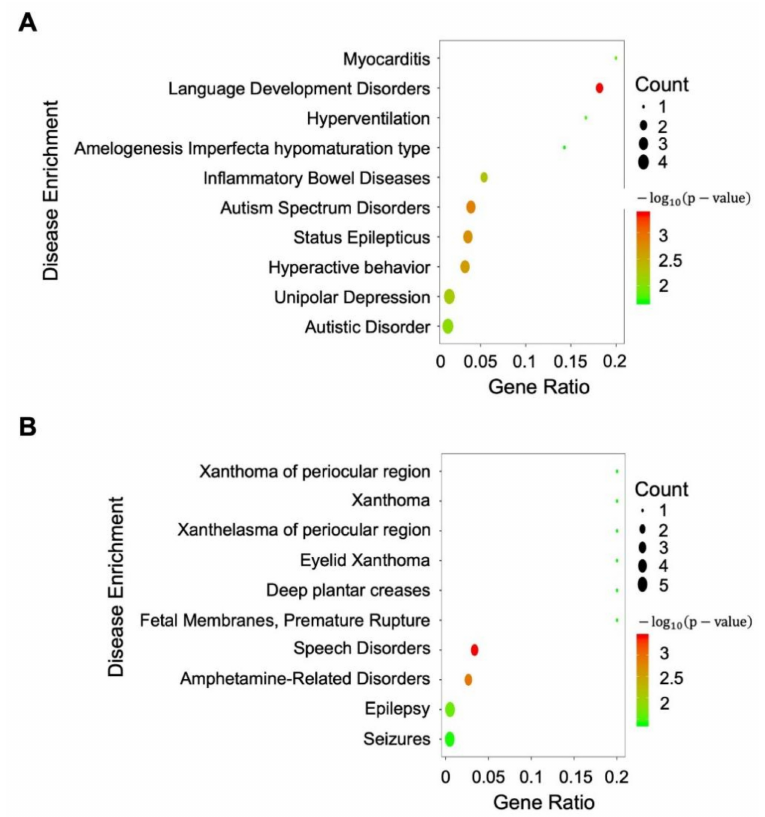
Figure 5. The pathway enrichment analysis of differentially expressed neighboring genes near differentially expressed HERVs. ( A ) For genes neighboring MER11B_LTR_ERVK; ( B ) for genes neighboring LTR21A_LTR_ERV1. The size of the dot represents the number of differentially expressed genes that are related to the corresponding disease identified. The color of the dot represents the confidence ( p -value) of the